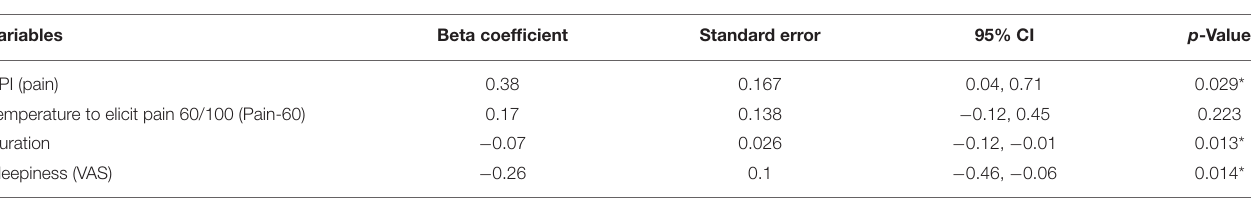
TABLE 4 | TSPS-phasic multivariate linear model.